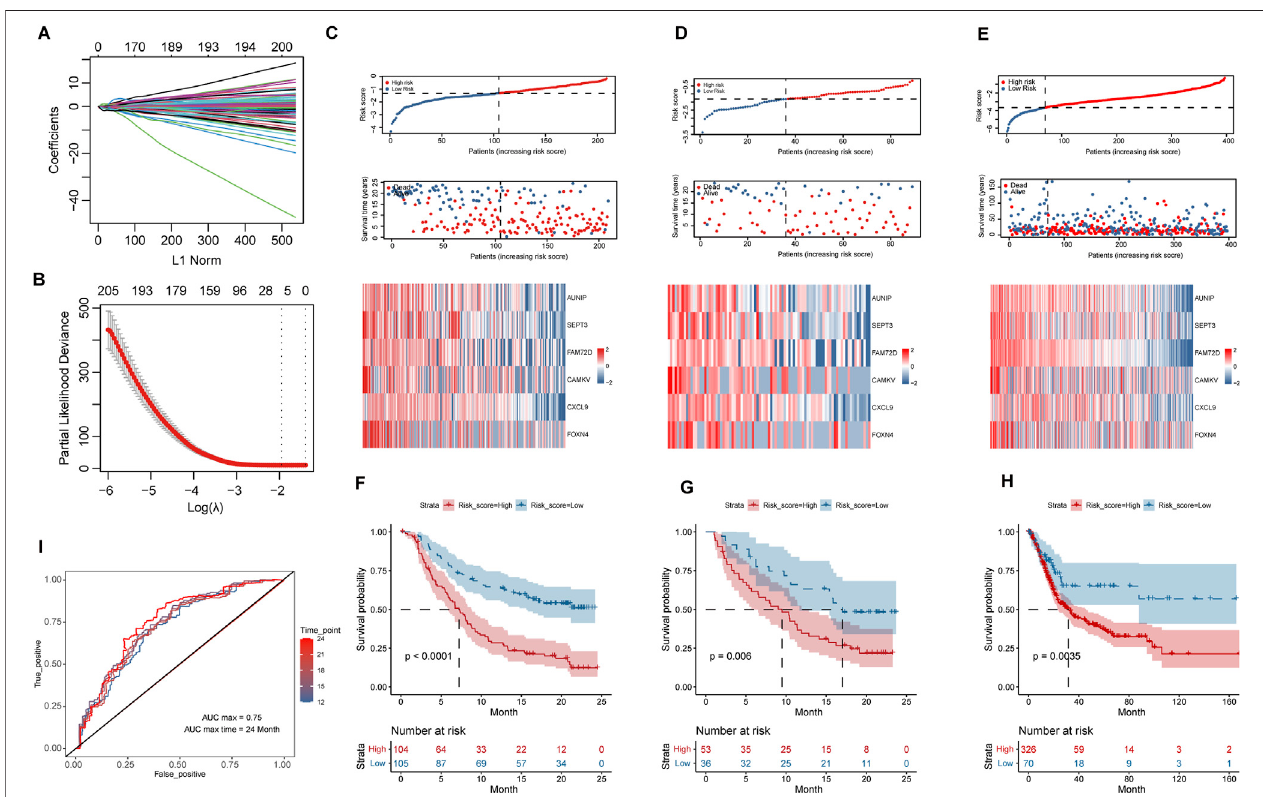
FIGURE 6 | Construction and validation of survival risk model after immunotherapy. (A,B) , Variables were fi ltered using LASSO regression, according to DEGs. (C – E) , Distribution of risk scores, survival status, and heat maps of hub variables in IMvigor210 training group and internal validation group, as well as TCGA_BLCA cohort. (F – H) , Kaplan-Meier survival analysis of high and low risk groups in IMvigor210 training group and internal validation group, and TCGA_BLCA cohort. (I) , Time- dependent ROC curves based on risk scores in the IMvigor210 cohort.